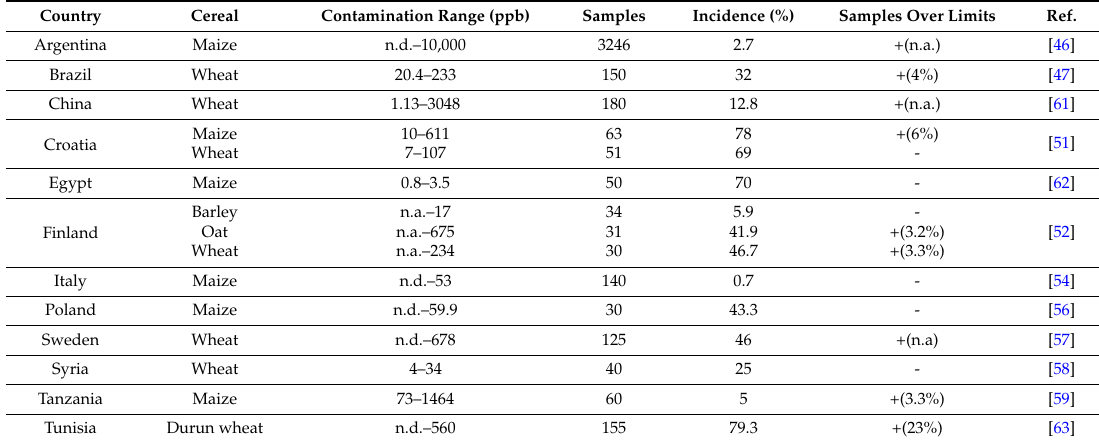
Table 3. Percentage and level of contamination in different countries and commodities relative to